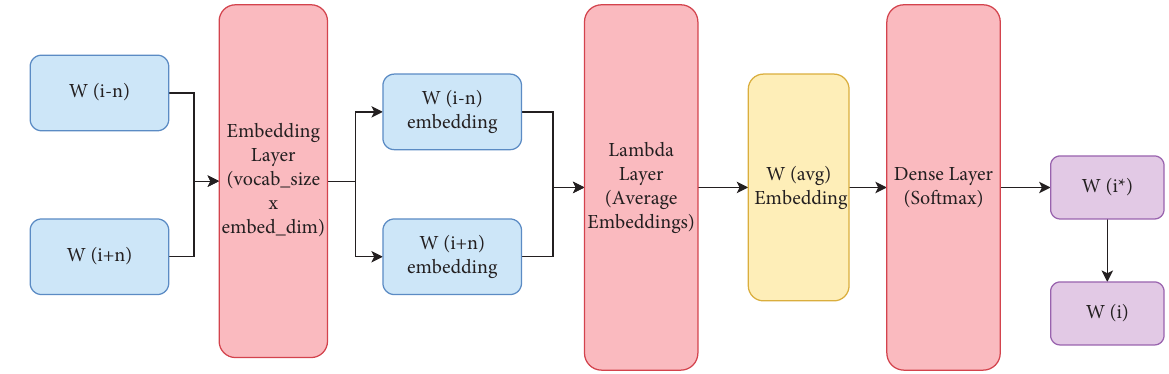
Figure 1: The structure of the CBOW